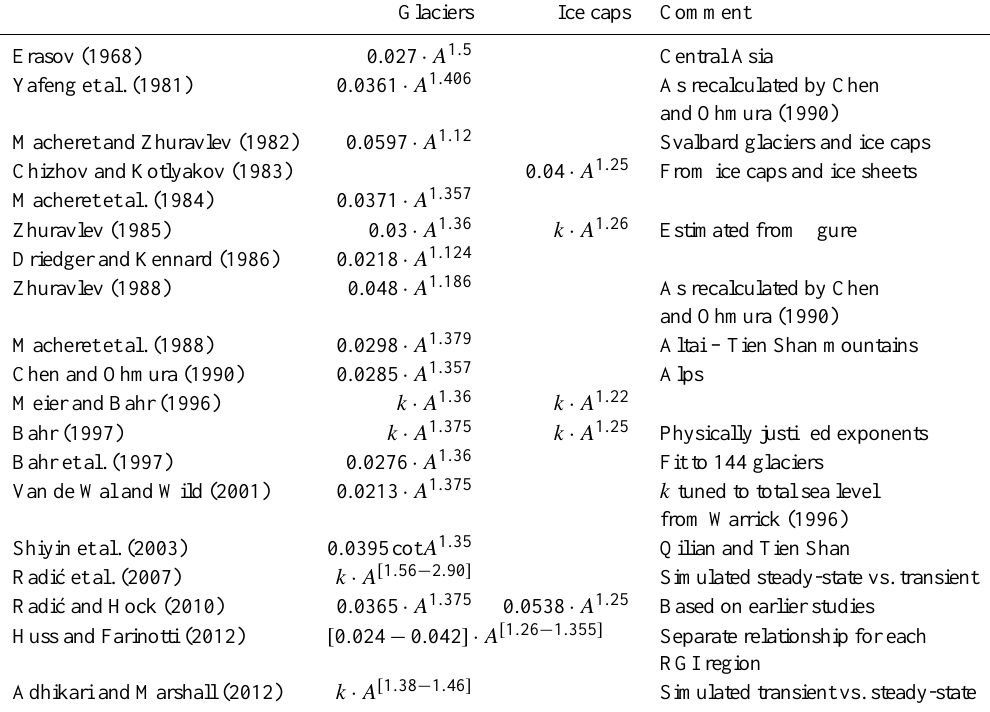
Table 1. Area–volume scaling laws found in the literature. Some of the cited studies operate with several relationships based on glacier type or